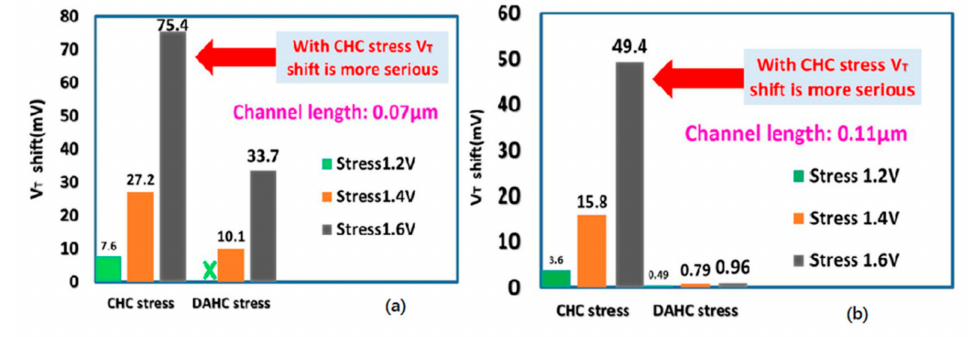
Figure 12. The V T shift compared the CHC test with the DAHC test as the tested devices: ( a ) W / L = 0.5 / 0.07 µ m / µ m and ( b ) 0.5 / 0.11 µ m / µ